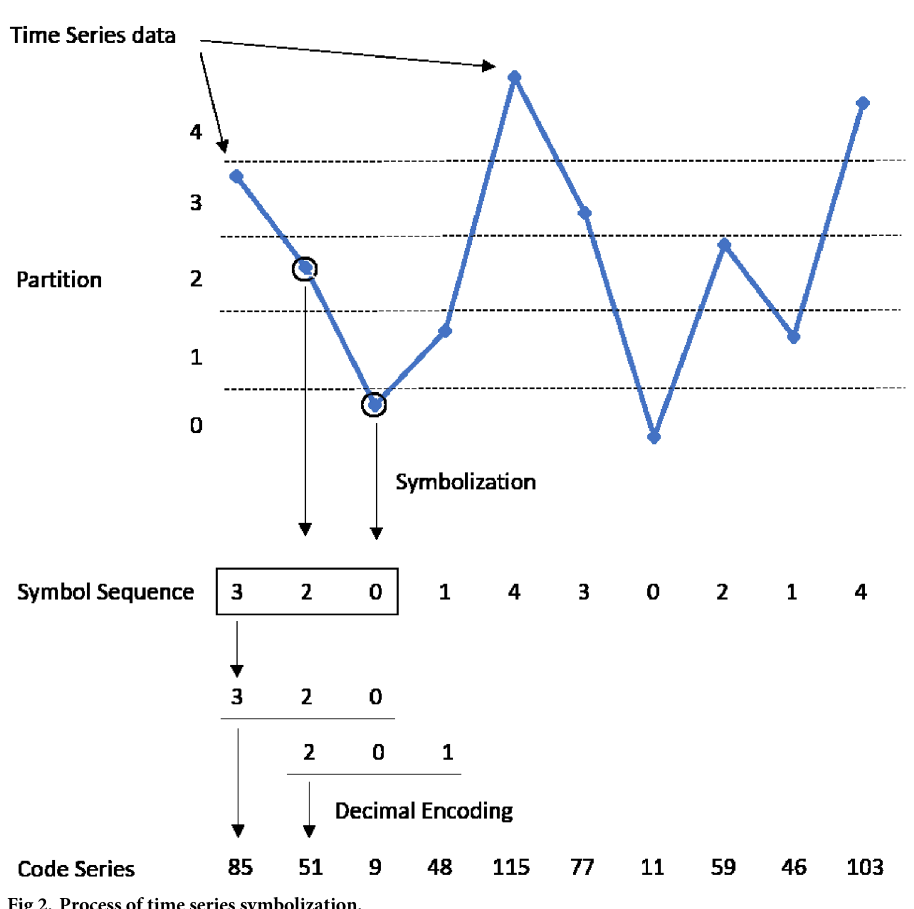
Fig 2. Process of time series